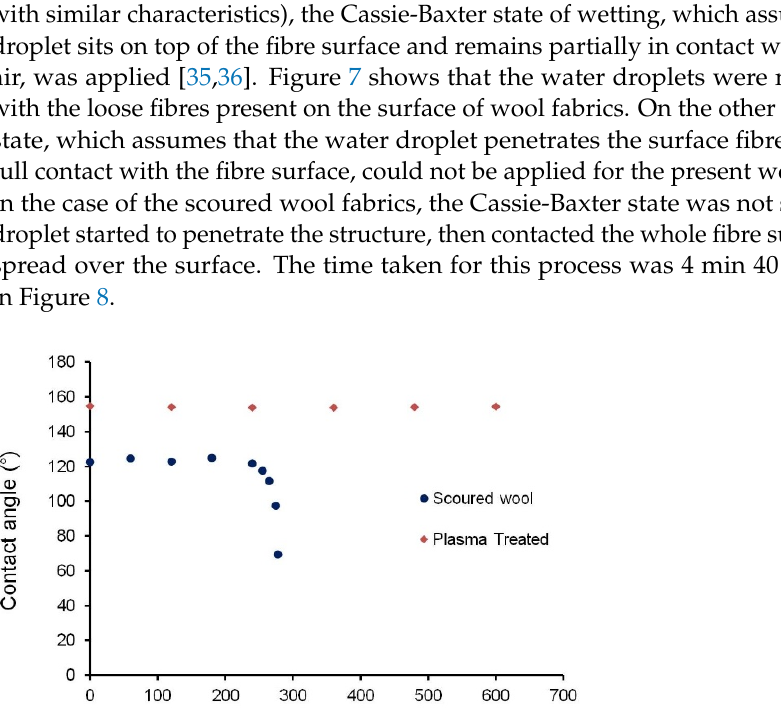
Table 3. Dye uptake and K/S values of untreated and plasma-treated wool fabrics.